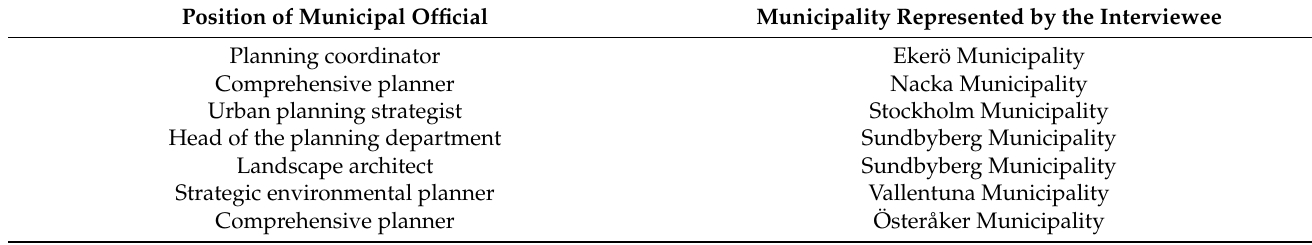
Table A1. List of participants in the focus group interview.